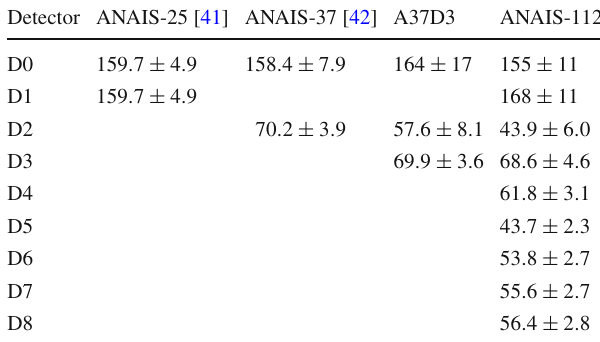
Table 6 Comparison of cosmogenically produced 22 Na initial (when moving detectors underground) activity, A 0 , estimated (in kg − 1 day − 1 ) for ANAIS detectors in different set-ups (see